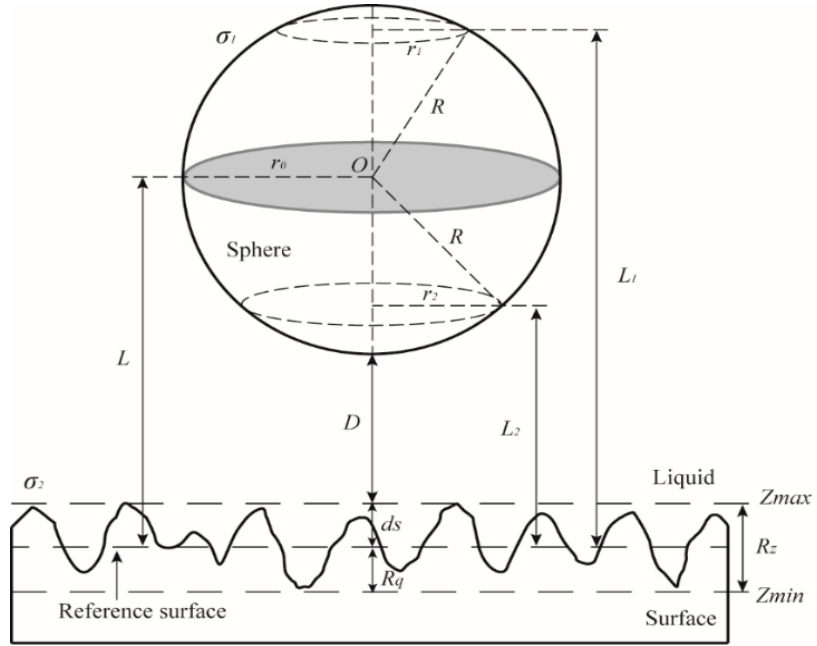
Figure 2. Schematic illustration of the charged sphere-rough surface system with electrostatic force between the sphere and the surface.